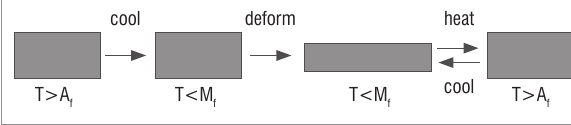
Figure 4: Two-way shape-memory effect.